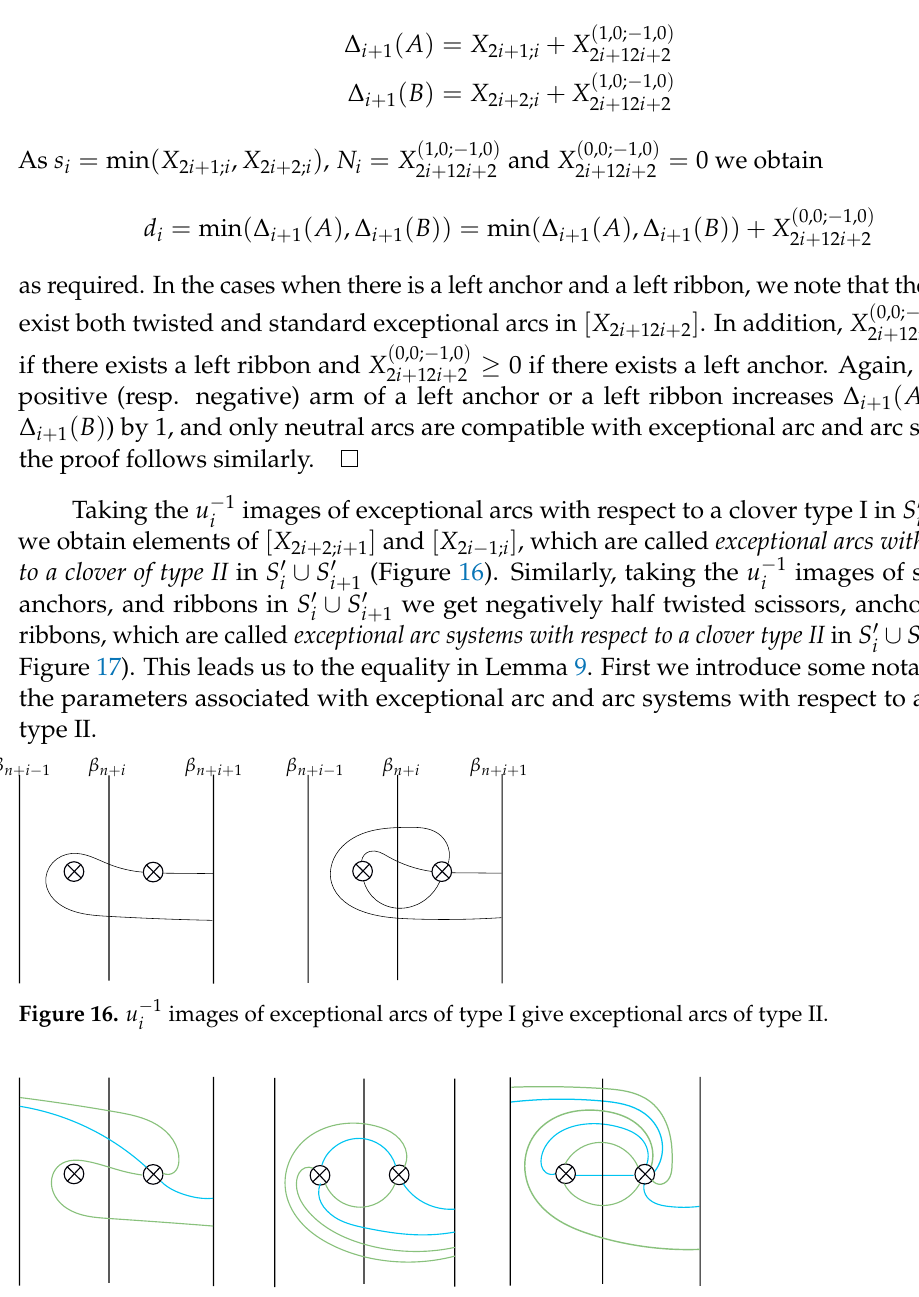
images of scissors, anchors, and ribbons, ordered from left to right, are exceptional arc Figure 17. u − 1 i systems with respect to a clover of type